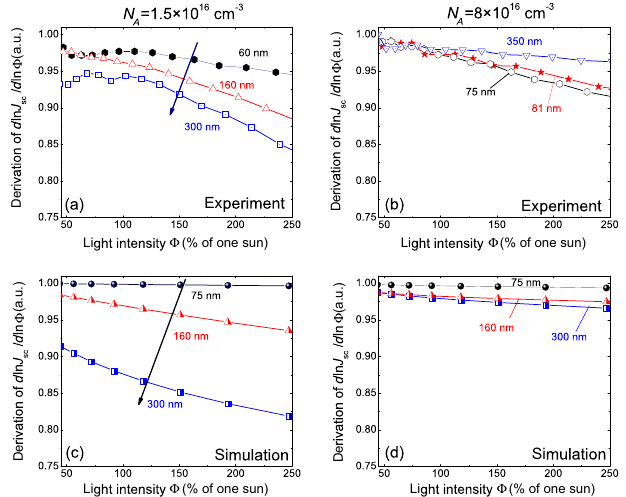
FIG. 5. Linearity of the short-circuit current J nation at different thicknesses for DPP-TT-T − PC 71 BM devices with a low level of doping [(a) experimental and (c) simulation] and a high level of doping [(b) experimental and (d) simulation]. The loss of linearity is compatible with the second-order loss process. However, the linearity does not appear to be degraded in the doped thickness series while there is substantial nongeminate recombination within the neutral